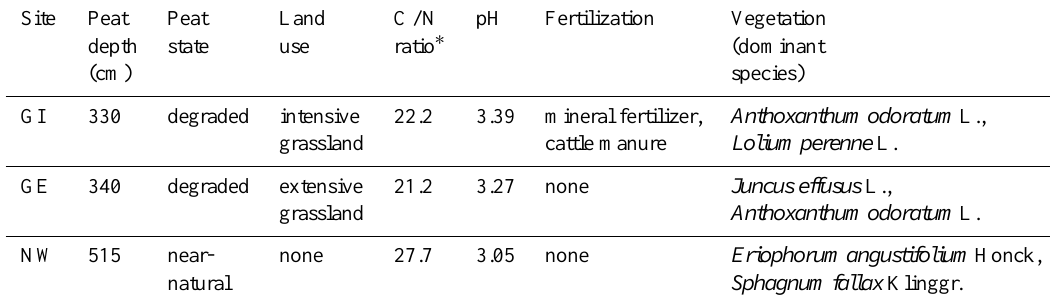
Table 1. Soil and land use characteristics of the research sites in the Ahlen-Falkenberger peat bog. Site Peat Peat Land C/N pH Fertilization Vegetation depth state use ratio ∗ (dominant (cm) species) GI 330 degraded intensive 22.2 3.39 mineral fertilizer, Anthoxanthum odoratum L., grassland cattle manure Lolium perenne L. GE 340 degraded extensive 21.2 3.27 none Juncus effusus L., grassland Anthoxanthum odoratum L. NW 515 near- none 27.7 3.05 none Eriophorum angustifolium Honck, natural Sphagnum fallax